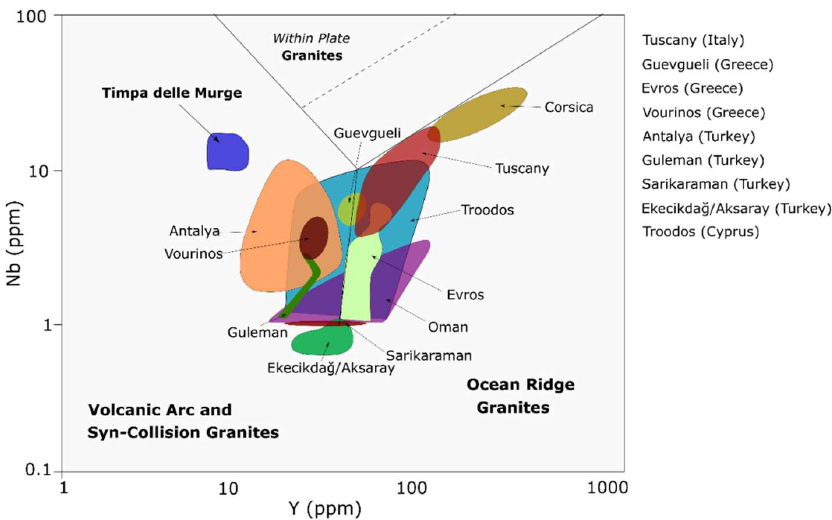
Figure 12. Y vs. Nb diagram of Timpa delle Murge leucocratic rocks and Tethyan plagiogranites displaying the fields of within plate granites (upper part), ocean ridge granites (on the right), and volcanic arc and syn-collisional granites (on the left)